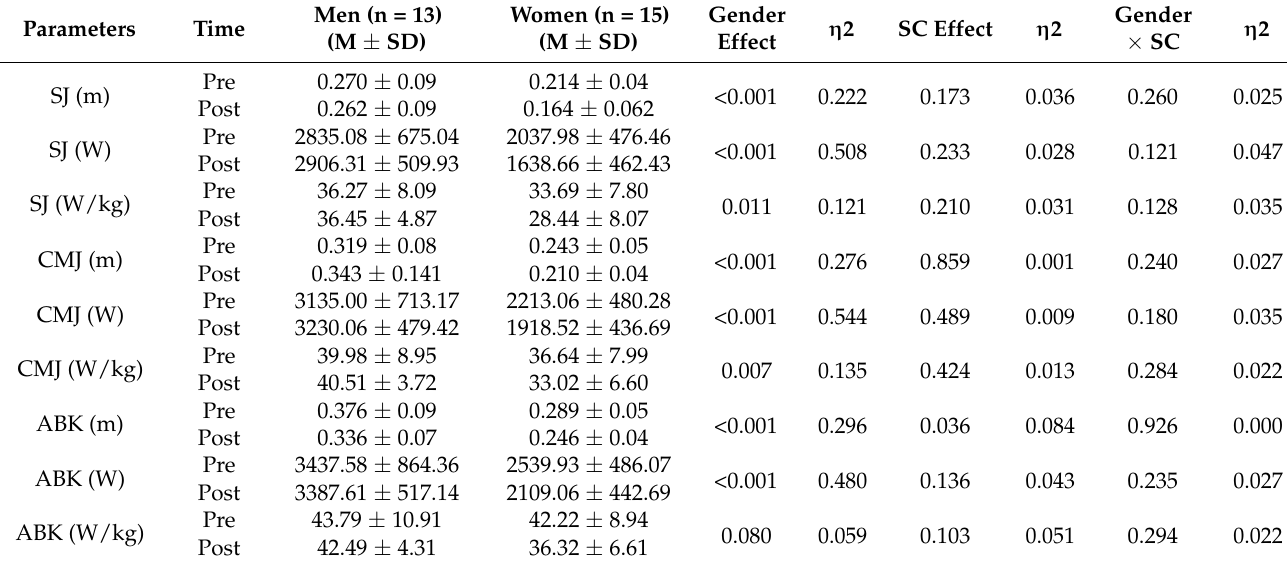
Table 4. Results obtained in the jump tests for both